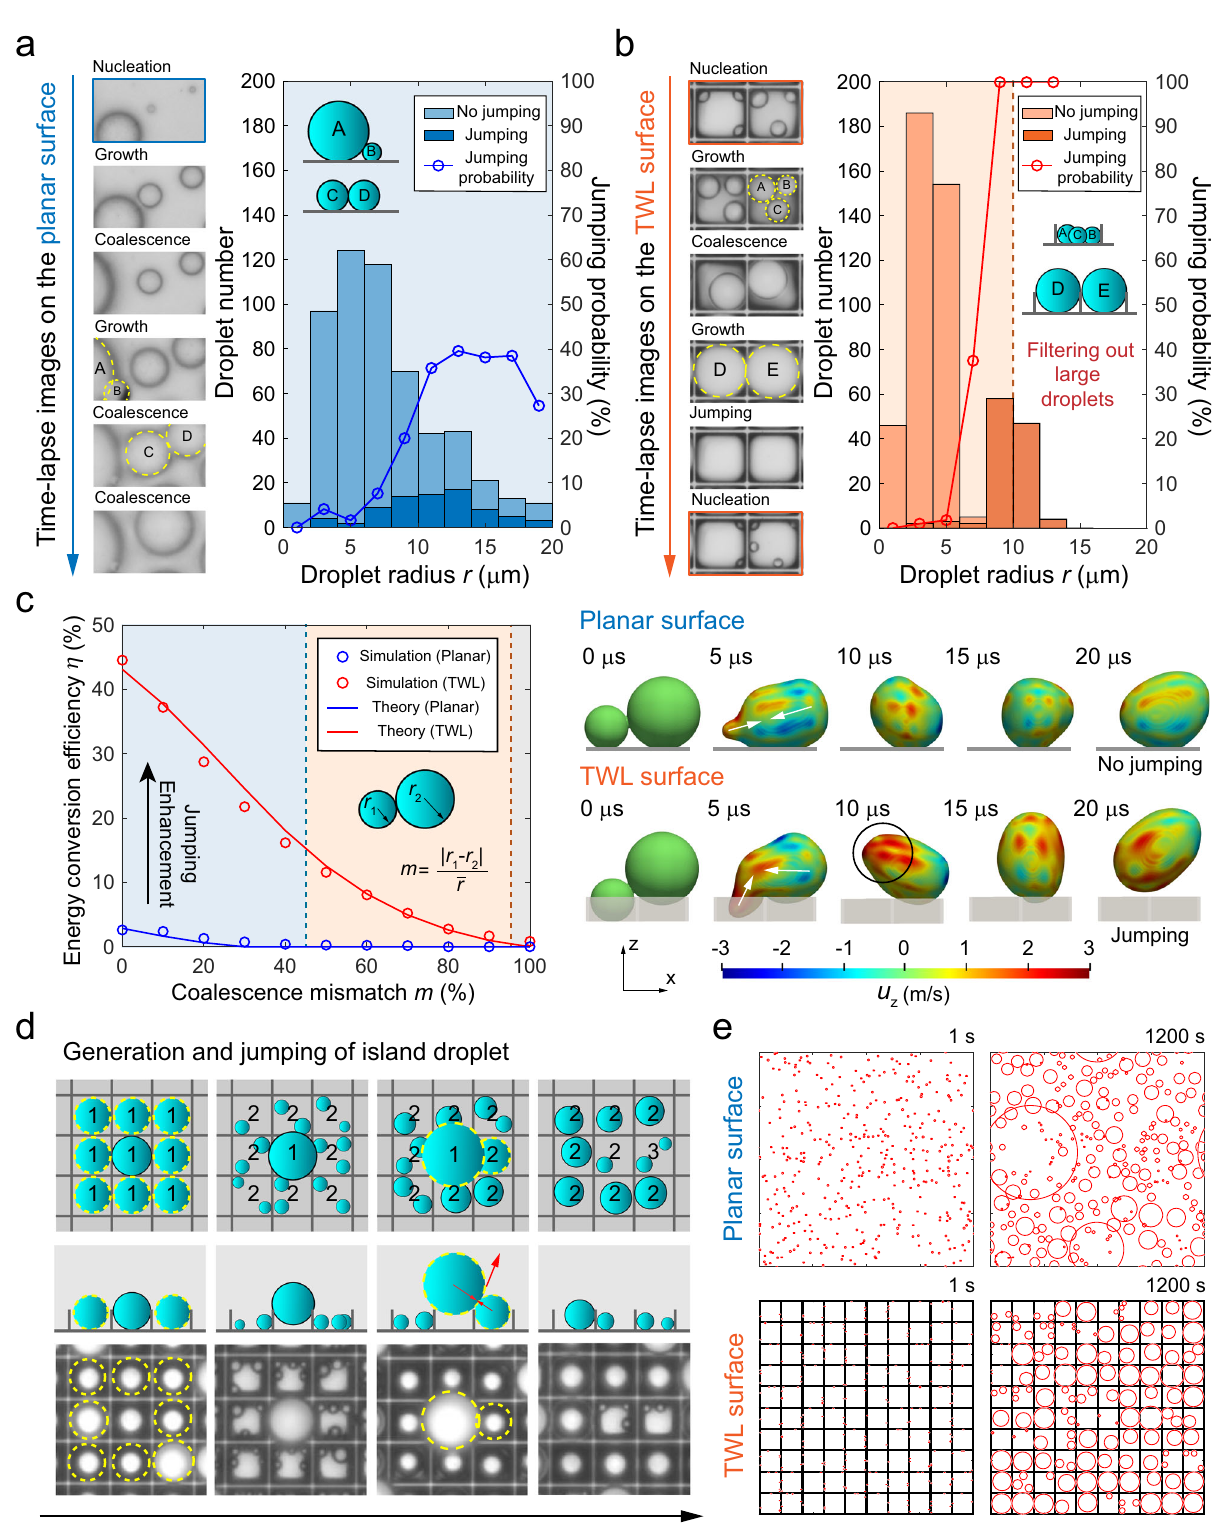
Fig. 3 | Investigation and veri fi cation of the mechanisms. a Time-lapse images and chart of jumping probability on the planar surface. Insets in the chart show the side views of droplets corresponding to those in the time-lapse images. Dark and light bars give the number of droplets that jump or do not jump after coales- cence, respectively, in evenly distributedradius ranges of 2 μ m. The solidline with circulardatadotsisthejumpingprobability. b Thearrangementhereisthesameas Fig. 3a, but the results are from the TWL surface. c Jumping dynamics on the two surfaces from VOF simulations. The left panel is the chart showing variation of